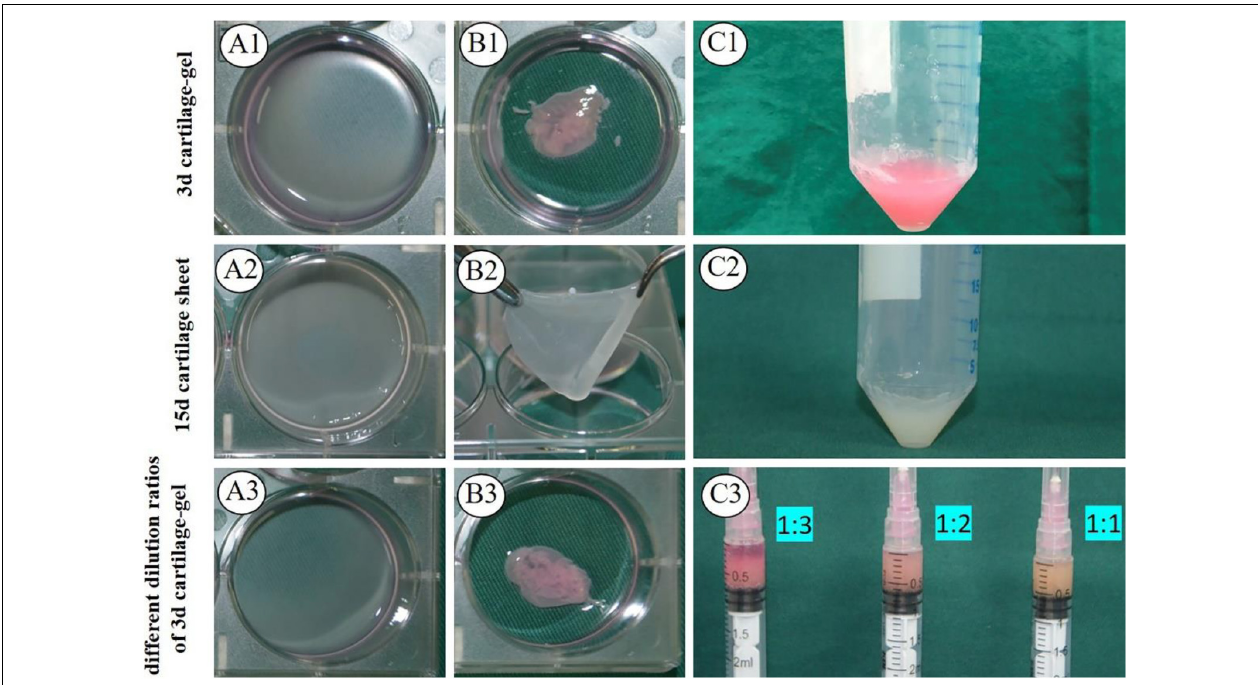
FIGURE 1 | Formation of engineered cartilage gel. Gross (A1) and mature status (B1) images of 3 d goat cartilage sheet and gross images (C1) of 3 d engineered cartilage gel (ECG). Gross (A2) and mature status (B2) images of 15 d goat cartilage sheet and gross images (C2) of 15 d ECG. Gross (A3) and mature status (B3) images of a 3 d human cartilage sheet and 3 d cartilage-gel in different dilution ratios (C3) .